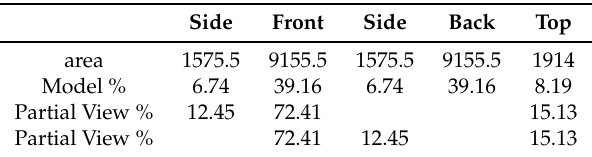
Figure 13. Graph models for the chest of drawers: in ( a ), the graph for the full model, and in ( b , c ), graphs for partial front views, left and right, respectively. Table 2. Example of the weights for the comparison of the chest of drawers graph, based on the area of each geometrical component.